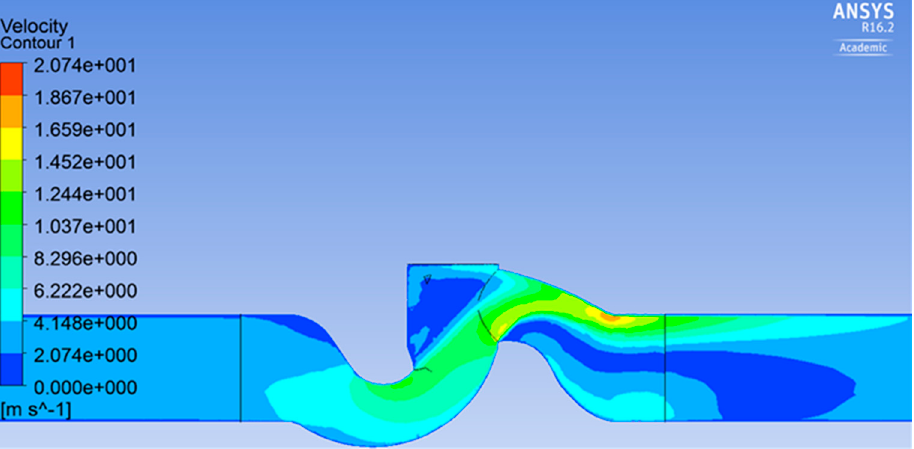
Figure 5. Fluid flow through extracted fluid profile of valve.